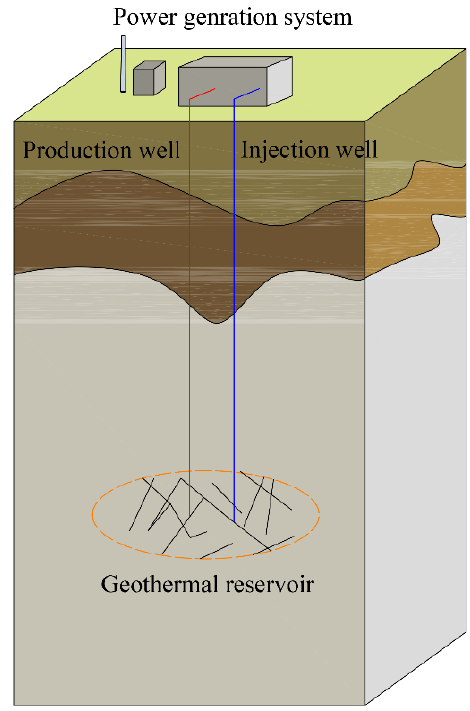
Figure 1. Schematic diagram of enhanced geothermal reservoir.